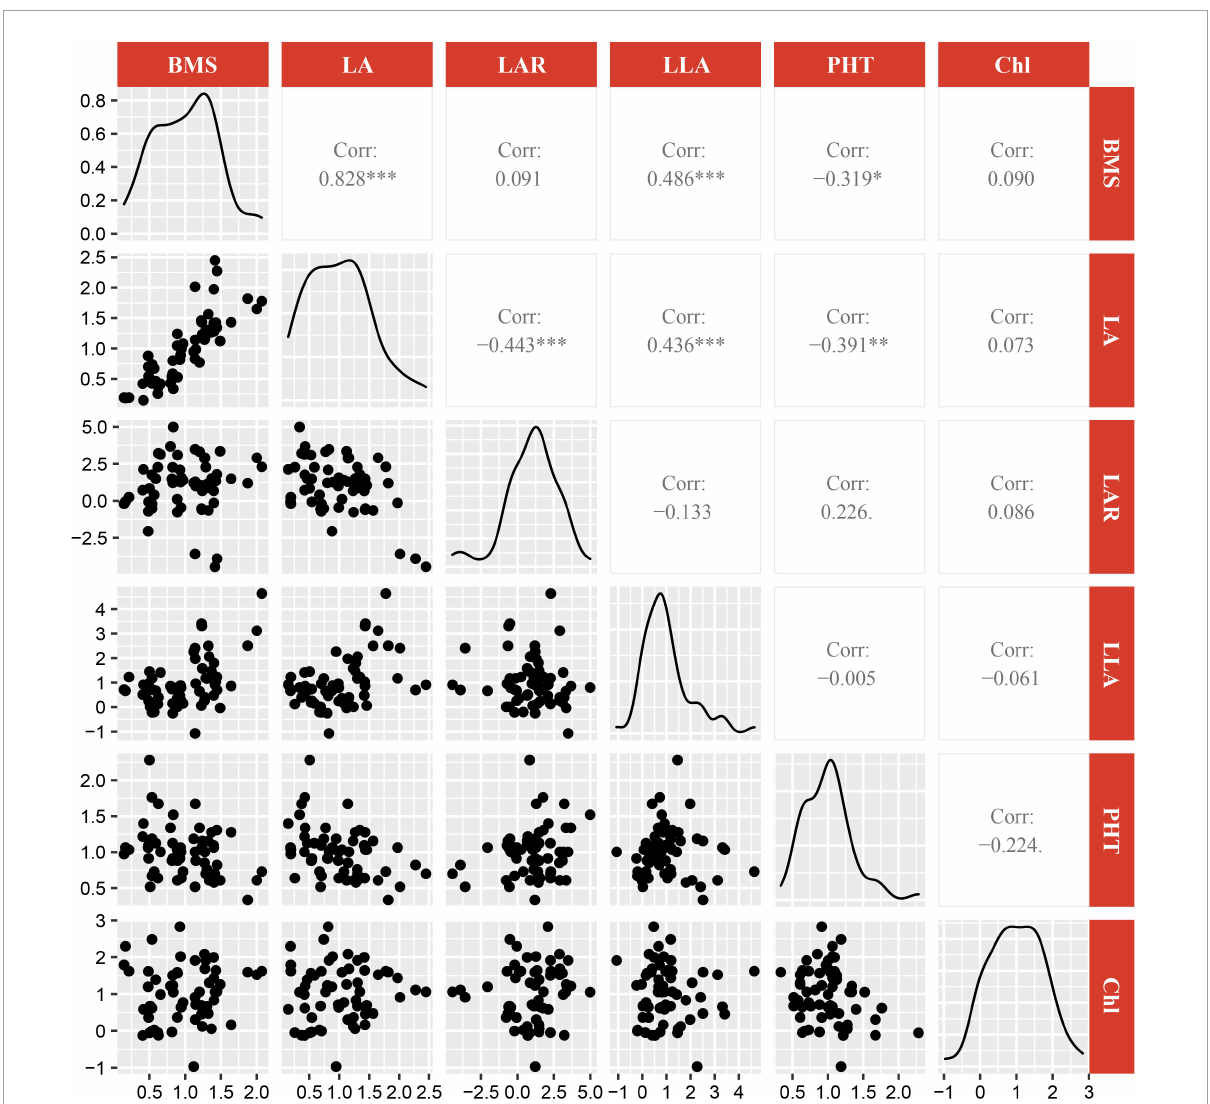
FIGURE5 Correlations between the plasticity of biomass and the plasticity of top five most important explanatory variables. BMS, biomass;LA, leaf area; LAR, leaf area ratio; LLA, leaflet area; PHT, plant height; Chl, Chl content. *, **, *** represent significant difference at 0.05, 0.01, and 0.001 levels,